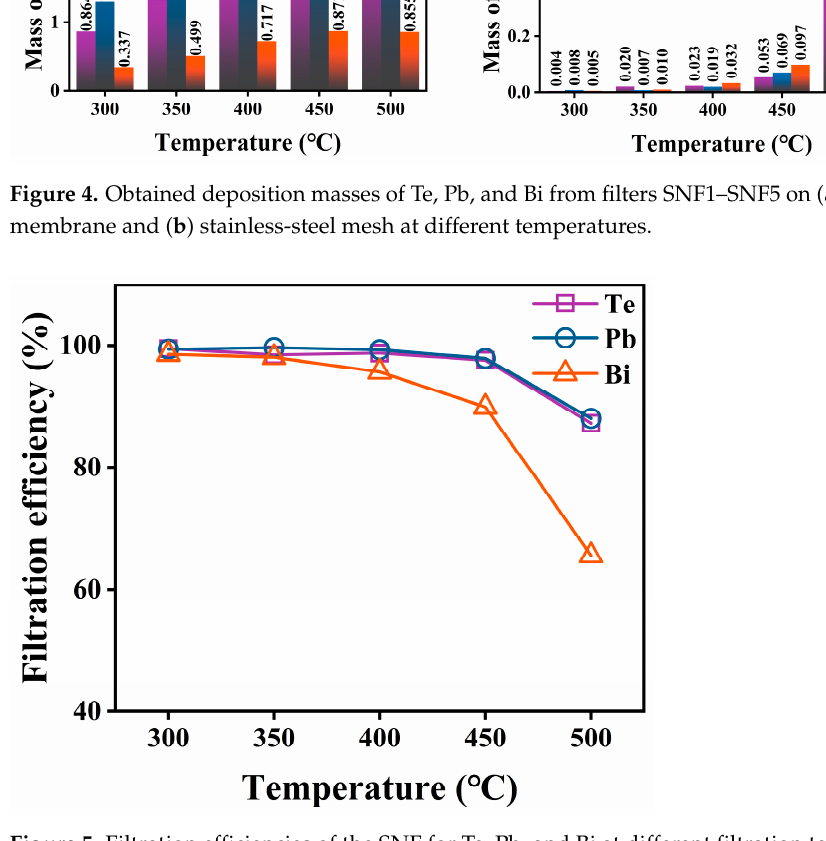
Figure 5. Filtration efficiencies of the SNF for Te, Pb, and Bi at different filtration temperatures.